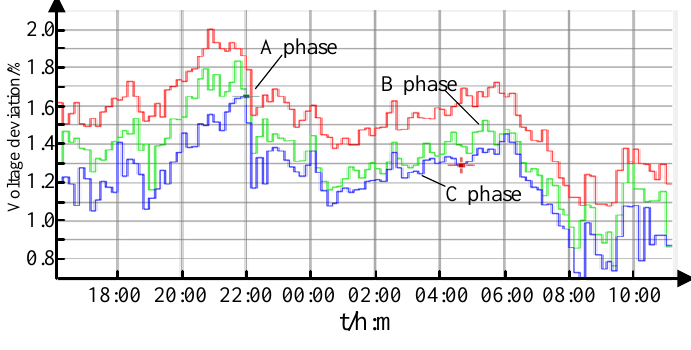
Figure 19. 500 kV bus voltage